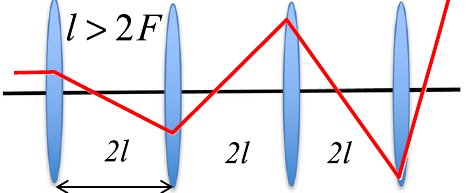
FIG. 1. A sketch of unstable ray trajectory in a system of periodic focusing lenses — an analog of broadband parametric resonance.